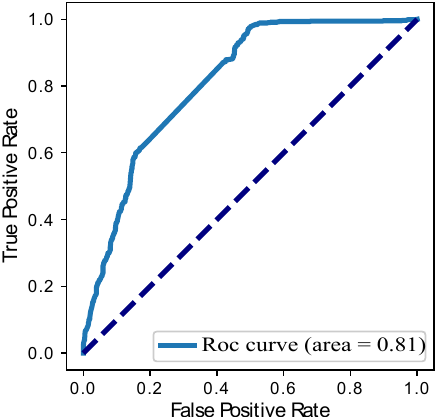
Figure 22. ROC curve of Multilayer Perceptron-Convolutional Neural Network (MLP-CNN).